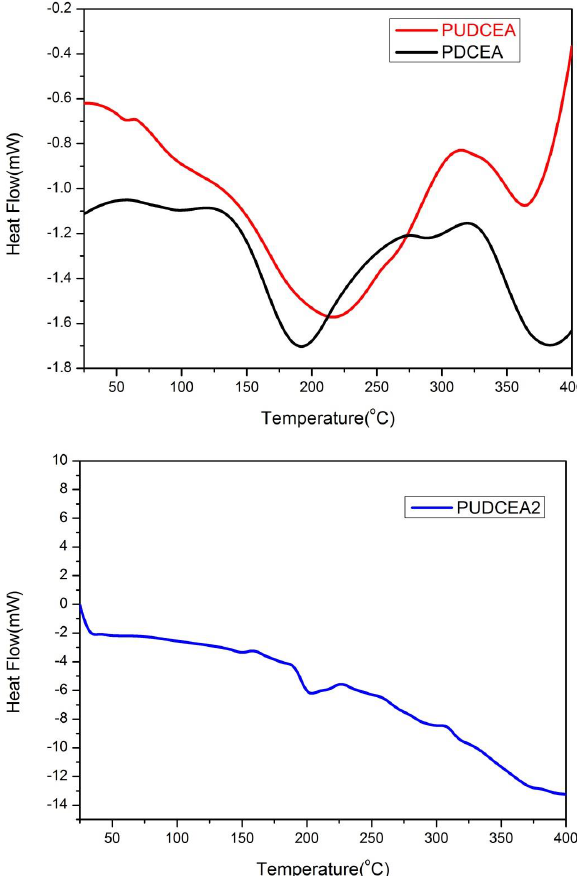
Figure 11. DSC thermogram of PDCEA, PUDCEA and PUDCEA-3. Figure 11: DSC thermogram of PDCEA, PUDCEA and